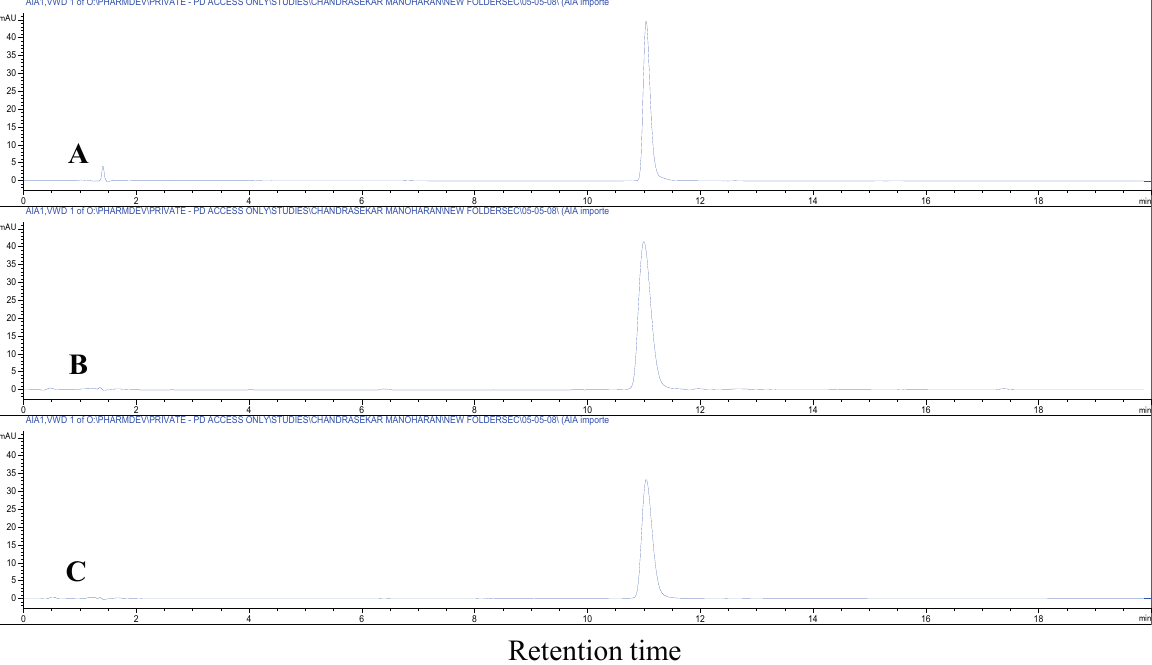
Figure 5. High performance liquid chromatography (HPLC) chromatograms of ( A ) native insulin; ( B ) insulin extracted after homogenization at 10,000 rpm; and ( C ) insulin with zinc extracted after homogenization at 10,000